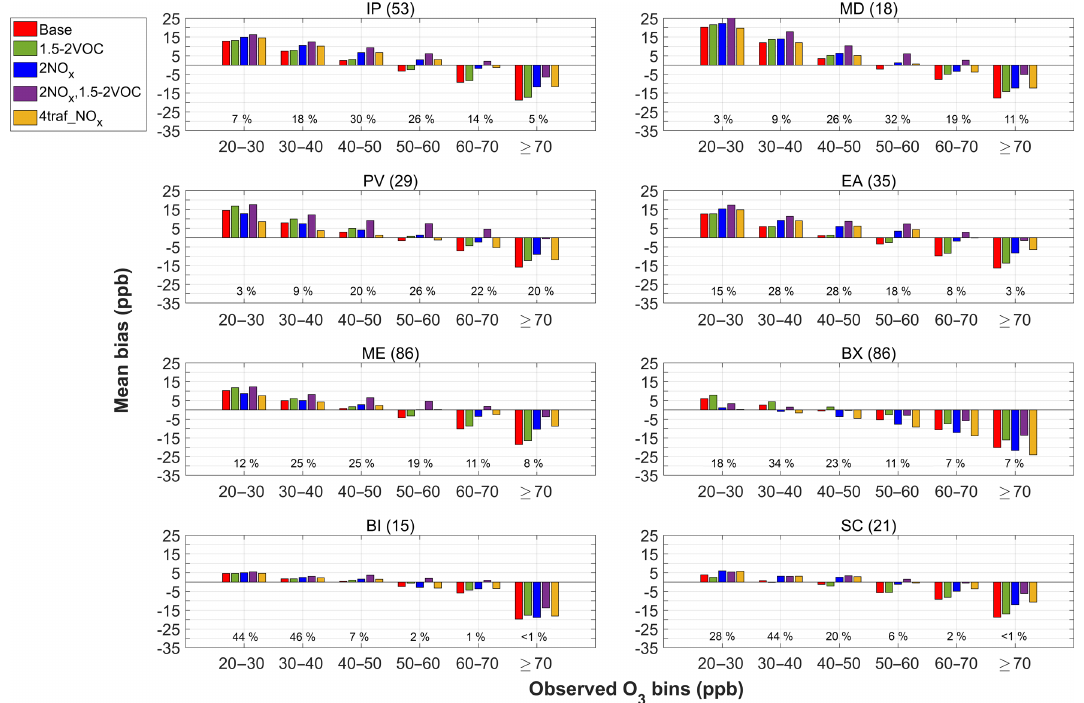
Figure 8. Mean bias of the afternoon (12:00–18:00UTC) surface O 3 mixing ratios for each bin of observed surface O 3 mixing ratios for various emission scenarios in eight European regions in summer 2010. Percentage values below the bars indicate the fraction of the values assigned to each bin for each region. The number of stations available for each region is reported in parentheses at the top of each panel. A definition of the regions is given in Fig.